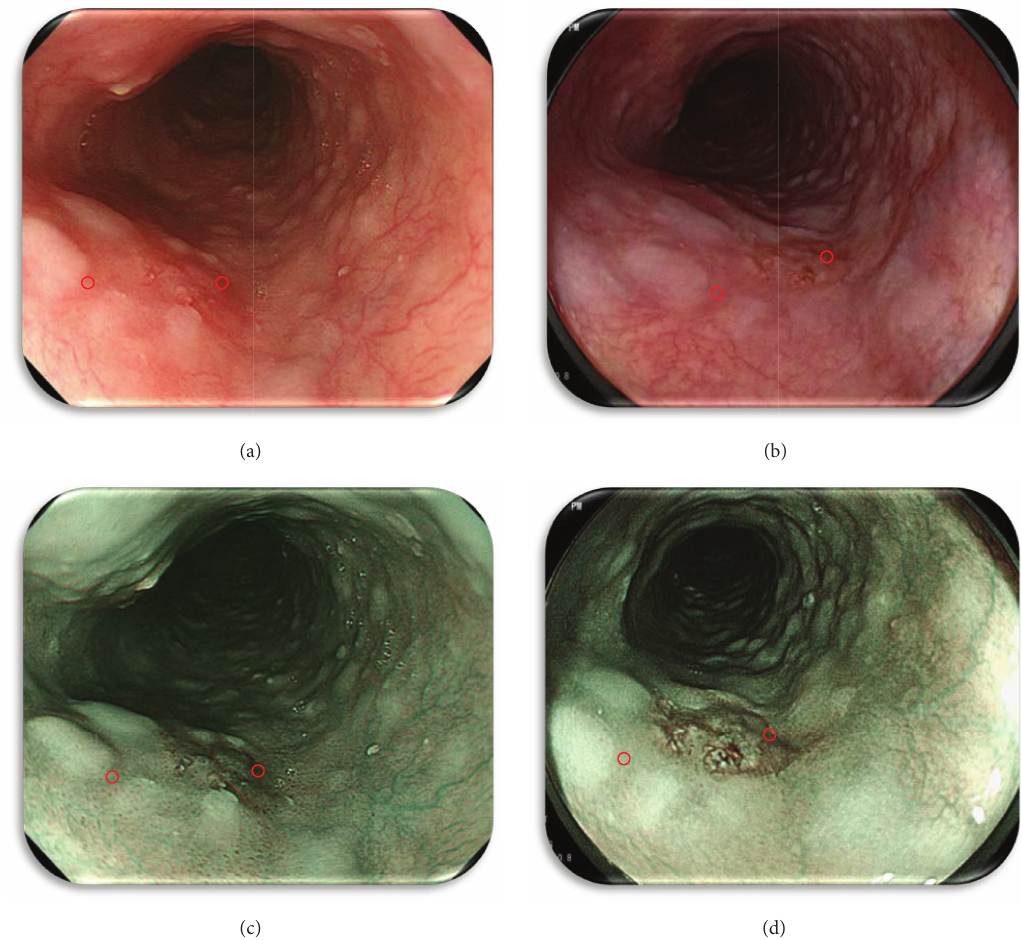
Figure 2: Representative still images illustrating the spots captured for the color difference score (CDS) calculation of the lesion and background mucosa (Figure 1). (a) O-WLI image, (b) F-WLI image, (c) NBI image, and (d) BLI-bright image. The lesion was captured for image processing, and the region of interest (ROI) was highlighted to calculate the CDS using each of the four methods.